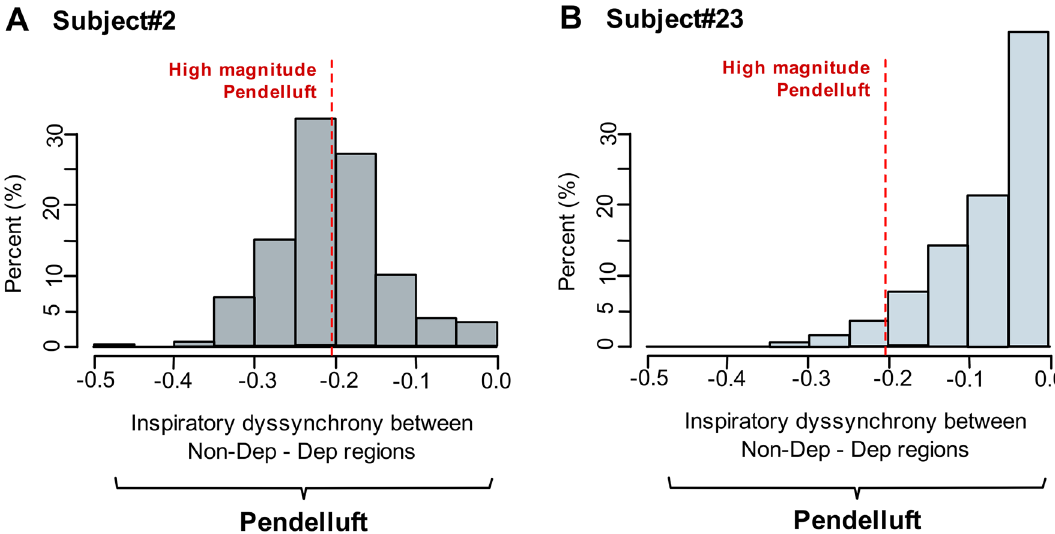
Figure 1. Histograms of inspiratory dyssynchrony (pendelluft) at different magnitudes. X axis corresponds to the magnitude of pendelluft and Y axis, to the percentage of ventilatory cycles with certain magnitude of pendelluft. The negative value of pendelluft represents the lost volume in non-dependent region during inspiration, expressed as fraction. The vertical red dotted line delimits the pendelluft with high magnitude cut- off − 0.2 (i.e. 20% of lost volume in non-dependent region during inspiration). ( A) corresponds to Subject #2 , a patient with a pendelluft mean of − 0.2 (− 20%), who presented high frequency of high-magnitude pendelluft. ( B ) corresponds to Subject #23, a patient with pendelluft mean of − 0.02 (− 0.2%), who presented low frequency of high-magnitude